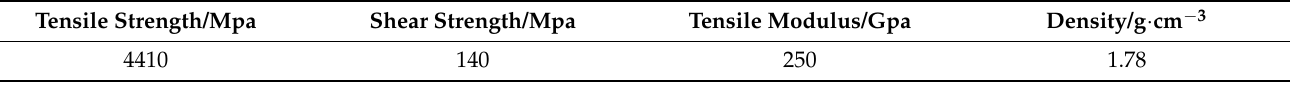
Figure 1. Structure of the woven CFRP. ( a ) CFRP material used in the experiment; ( b ) woven structure of the carbon fiber; ( c ) cutaway view of the plain-woven CFRP. Table 1. Mechanical properties of the CFRP.